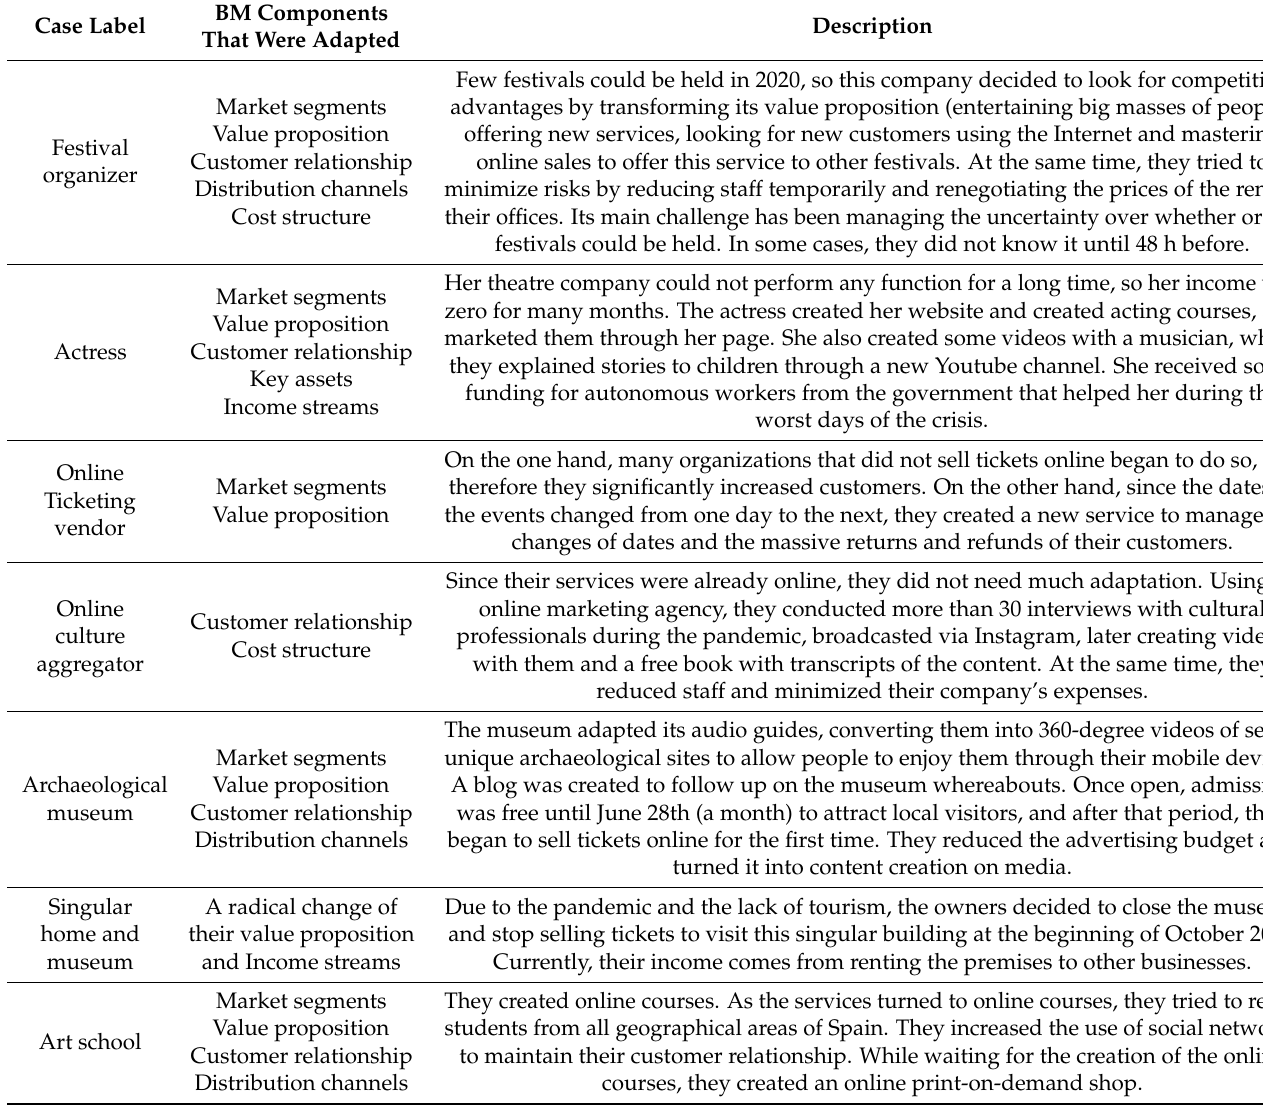
Table 3. Changes in the business